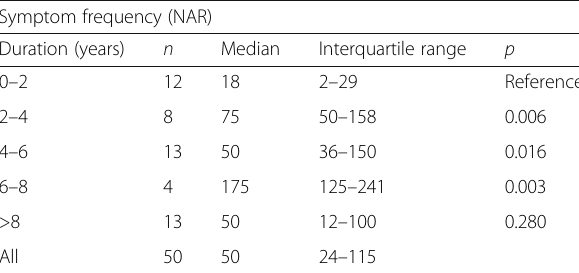
Table 2 RBD symptom frequencies in every 2-year bin of RBD